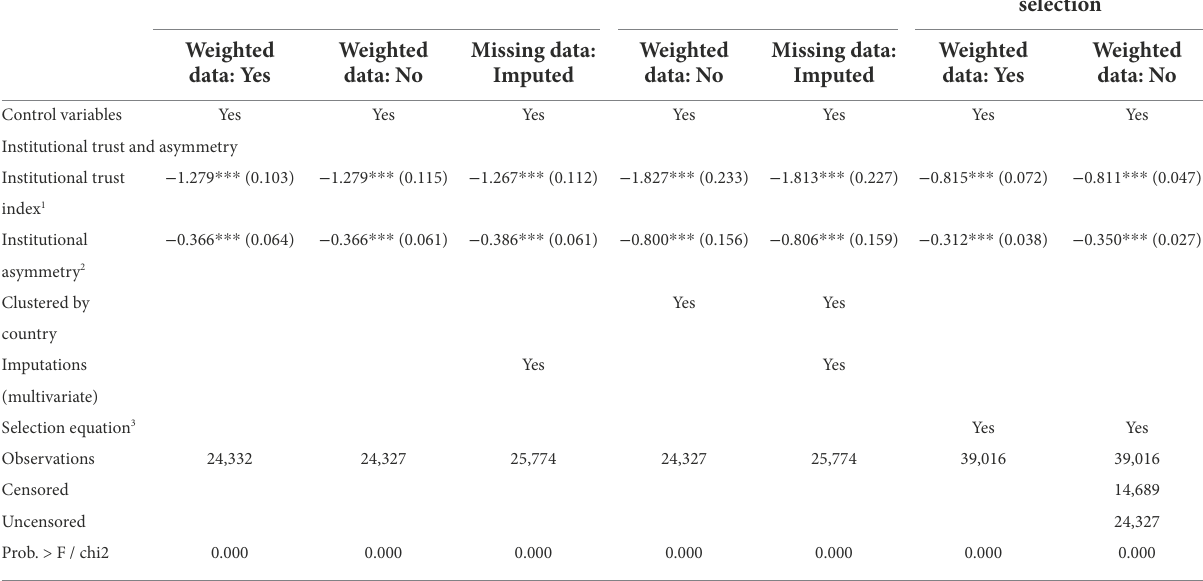
TABLE 3 Sensitivity tests.